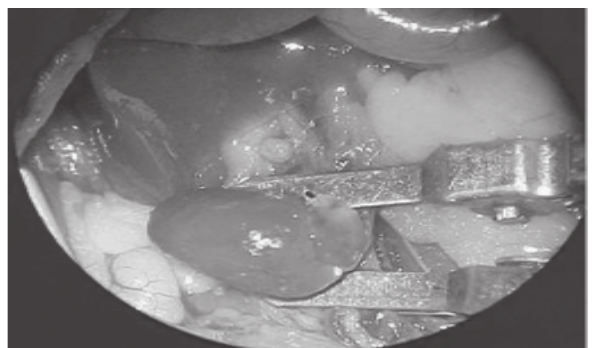
Fig. 1 – Transplante cardíaco: implantação do enxerto cardíaco - anastomose término-lateral da aorta do doador com a do receptor e anastomose término-lateral da artéria pulmonar do doador com a veia cava inferior do receptor (16 X)